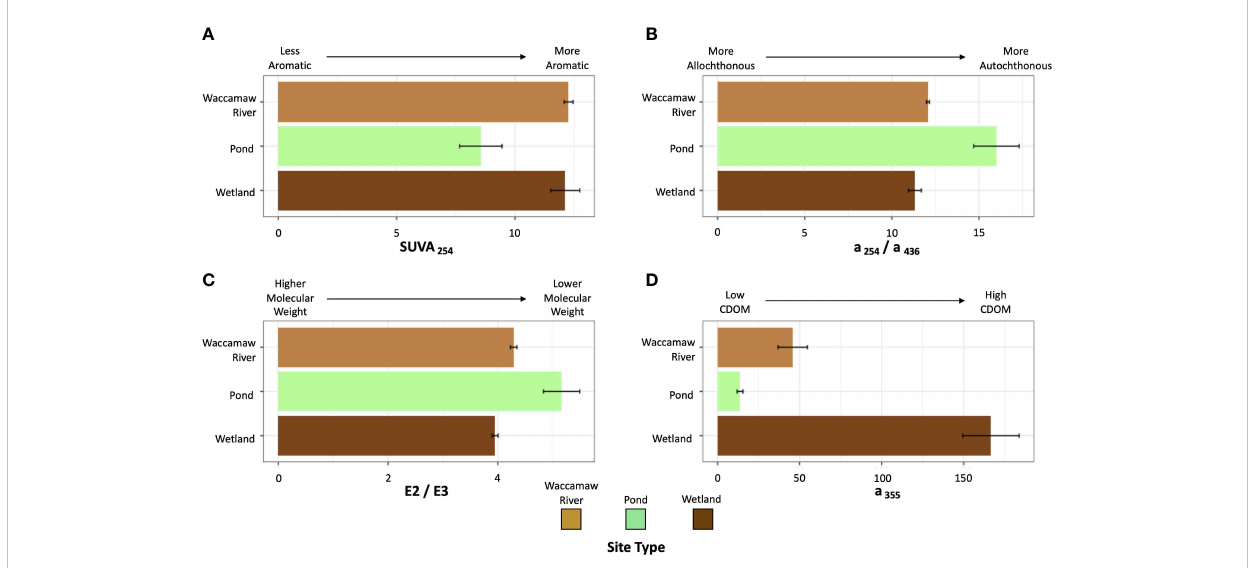
FIGURE 6 Bar graphs depicting a variety of dissolved organic matter spectral metrics as averages, with error bars representing standard error. Bars are grouped and colored by site type: forested wetlands (dark brown), stormwater detention ponds (green), and Waccamaw River (light brown). The metrics are (A) SUVA 254 (degree of aromaticity), (B) a 254 /a 436 (allochthonous vs autochthonous), (C) E2/E3 (inverse to molecular weight), and (D) a 355 (quantity of chromophoric dissolved organic matter;